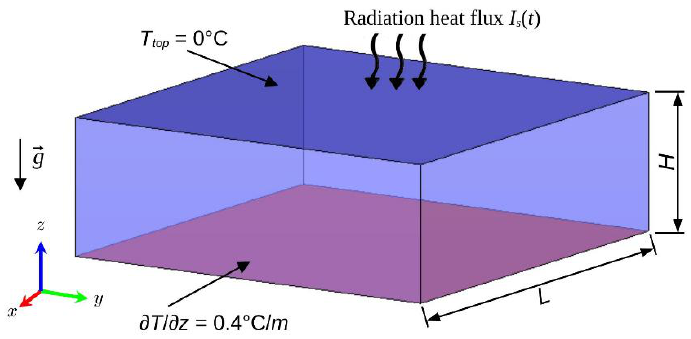
Figure 1. Computational domain and thermal boundary conditions.